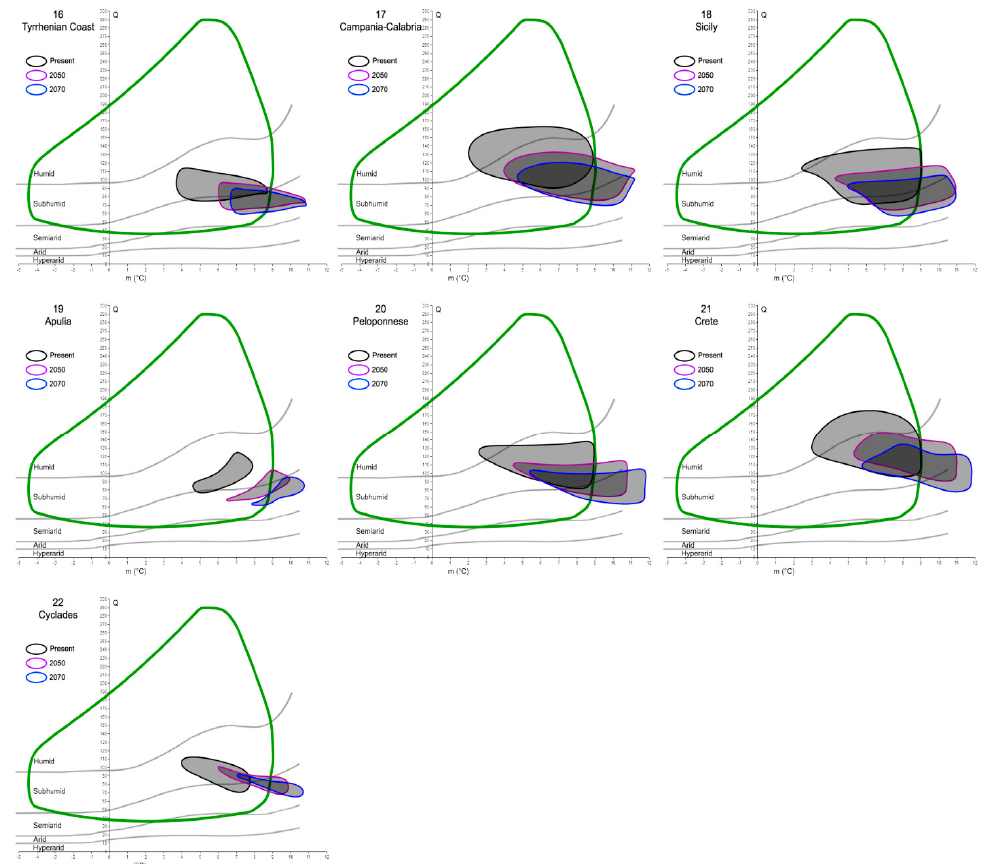
Figure 4. Mosaic of Emberger’s climatograms for the 22 cork oak putative refugia proposed by Vessella et al. [36]. Black closed lines encompass the Q - m values detected within each area at present time. Purple and blue lines show what the Q - m values of the same areas would be in 2050 and 2070, respectively. The green curve represents the cork oak climatogram, as in Figure 3.